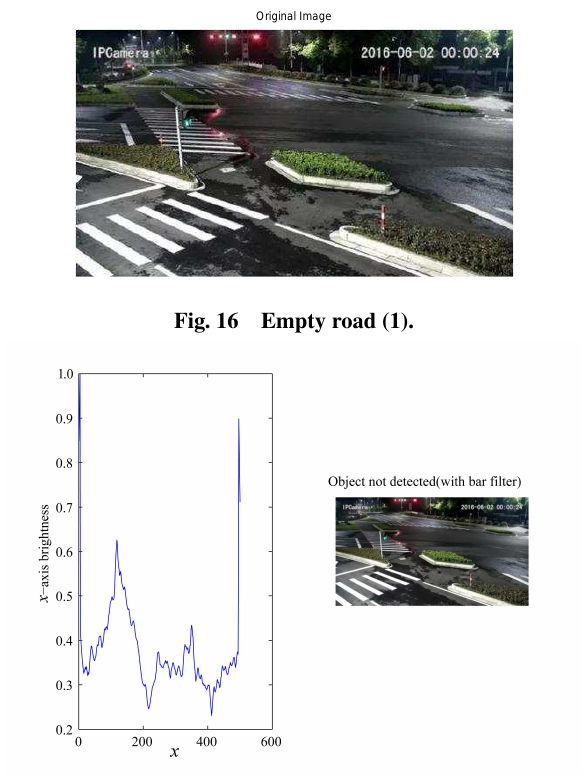
Fig. 17 Horizontal axis’ brightness values and search result (with bar filter) according to Fig. 16.